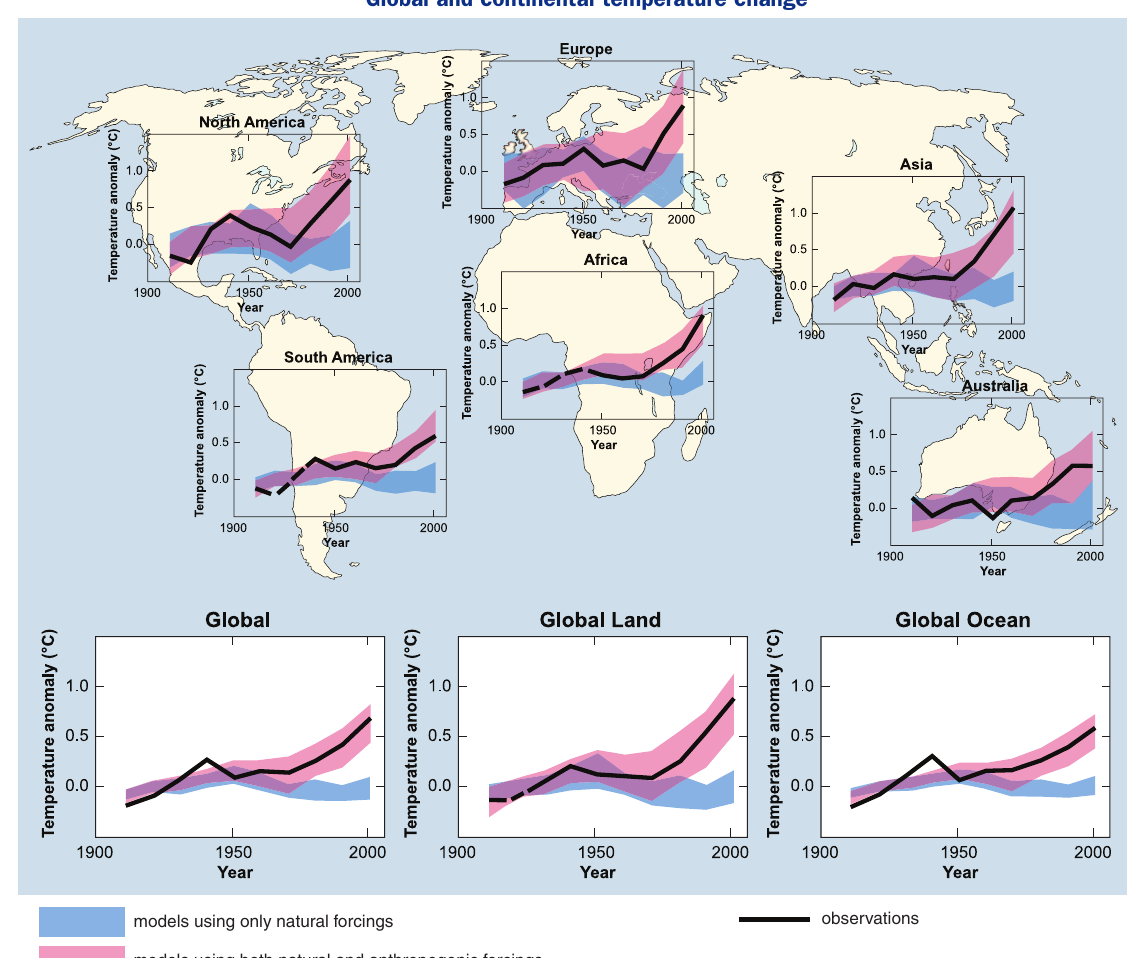
Figure SPM.4. Comparison of observed continental- and global-scale changes in surface temperature with results simulated by climate models using either natural or both natural and anthropogenic forcings. Decadal averages of observations are shown for the period 1906-2005 (black line) plotted against the centre of the decade and relative to the corresponding average for the period 1901-1950. Lines are dashed where spatial coverage is less than 50%. Blue shaded bands show the 5 to 95% range for 19 simulations from five climate models using only the natural forcings due to solar activity and volcanoes. Red shaded bands show the 5 to 95% range for 58 simulations from 14 climate models using